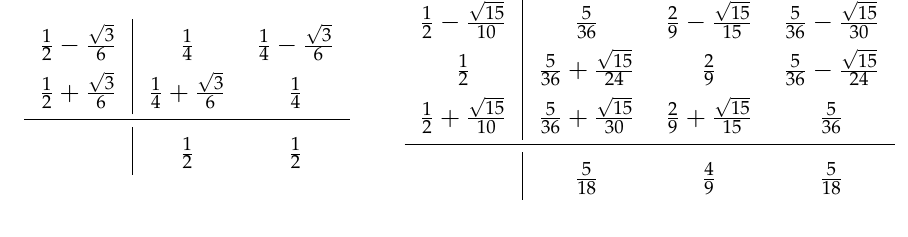
Table 1. Coefficients of RK methods of order 4 (left) and 6 (right).